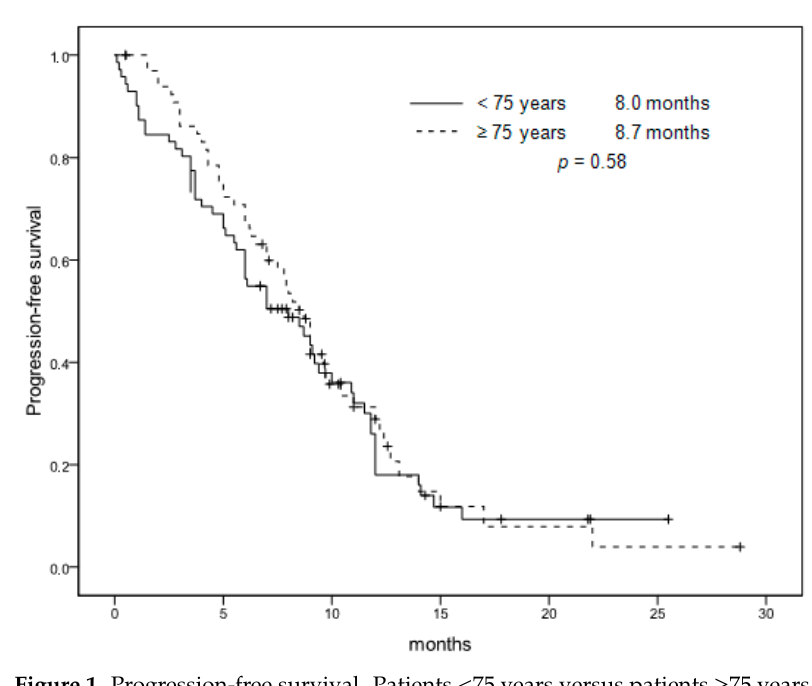
Figure 1. Progression-free survival. Patients <75 years versus patients ≥ 75 years. Cancers 2019 , 11 , x